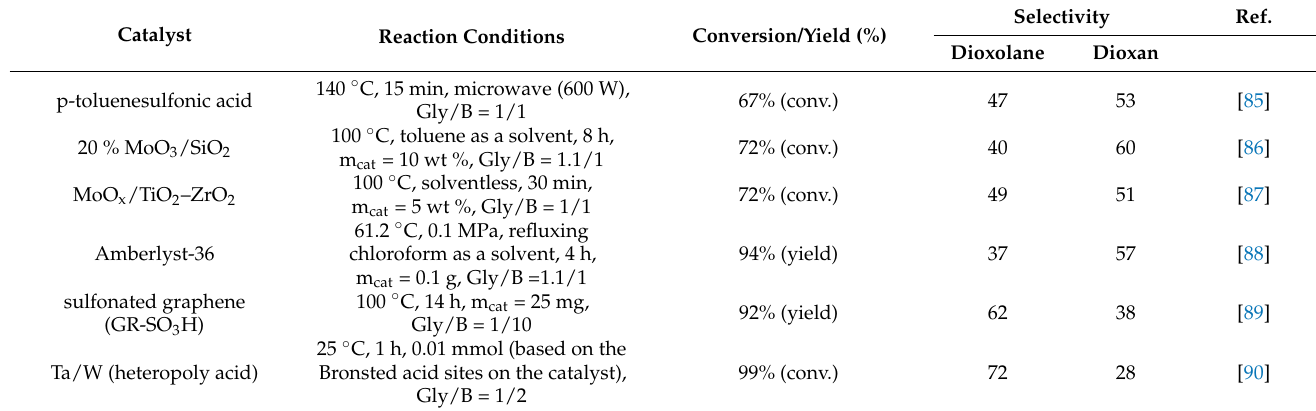
Table 8. Acetalization of glycerol with benzaldehyde over other solid acid catalysts.